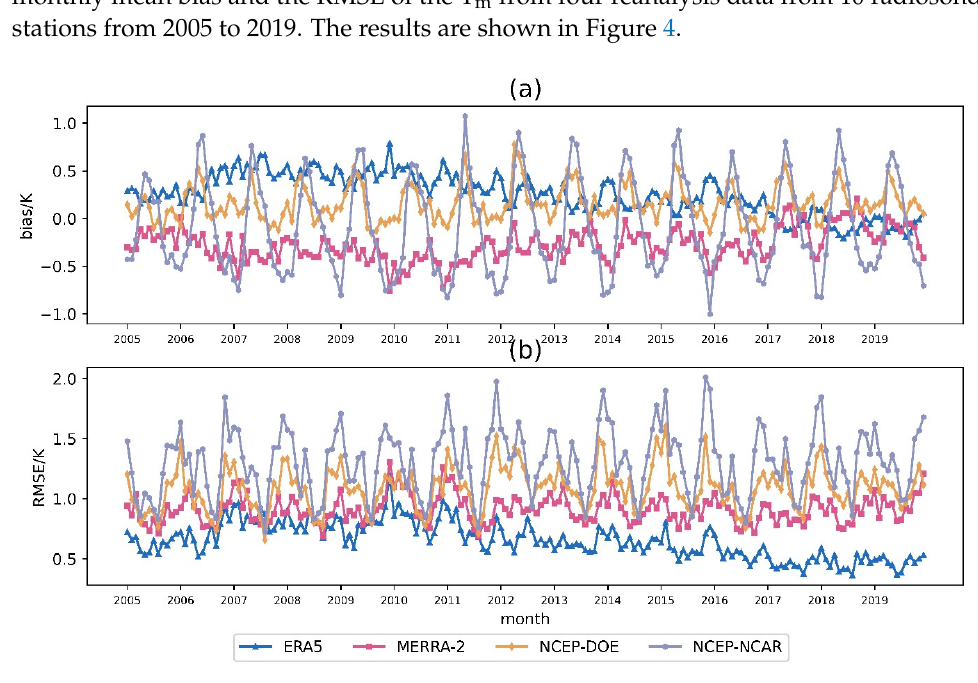
Figure 4. Monthly mean ( a ) bias and ( b ) RMSE of T m of 10 stations from 2005 to 2019 calculated from four reanalysis data.